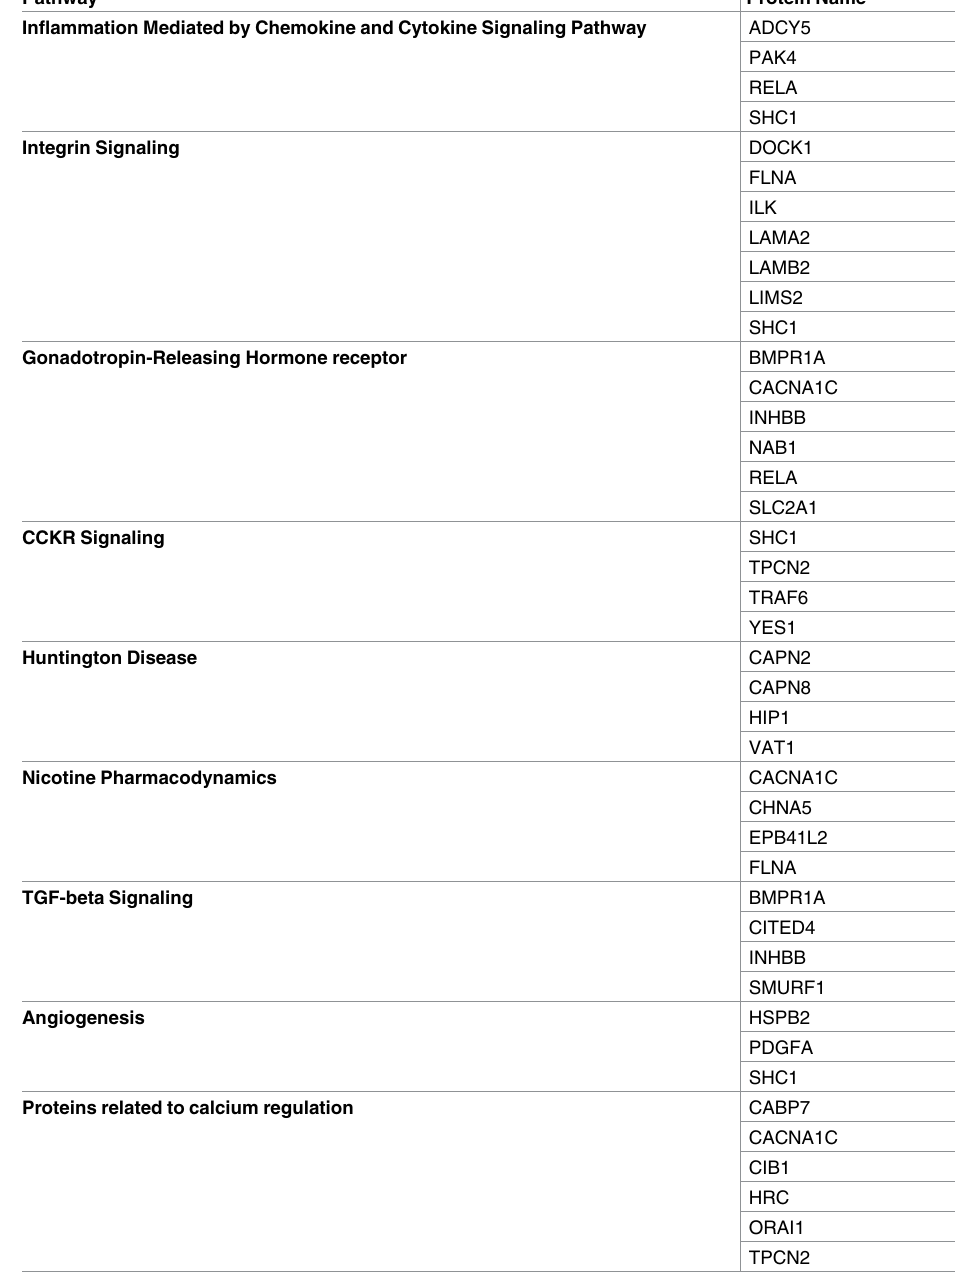
Table 9. Functionally-related groups of brain vascularmarkersidentified from the Human Protein Atlas. Clusters of functionally related proteinswere identified in brain vessels using PANTHER analysisand are listed in groupsthat containmore than 3 proteins. Proteins related to calcium regulation are also